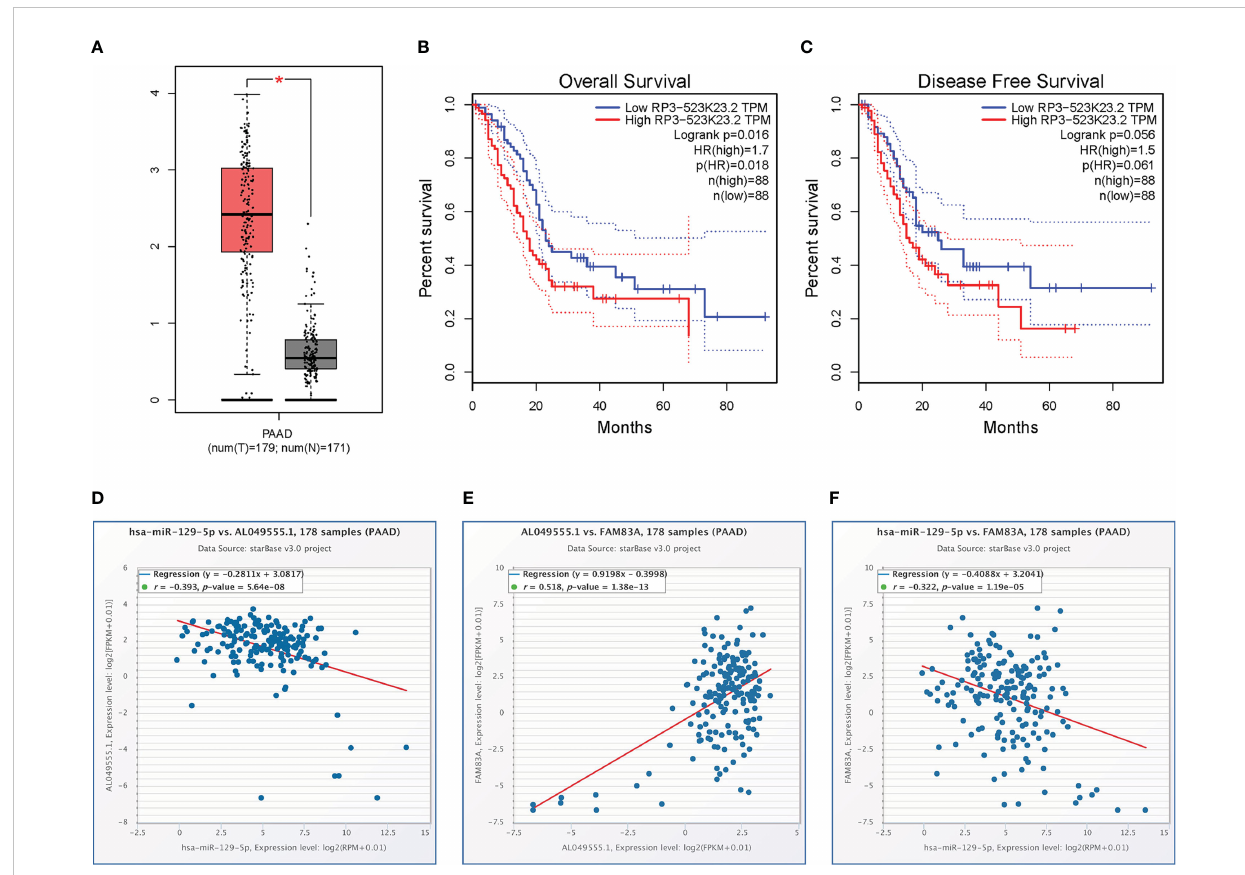
FIGURE 5 Expression analysis and survival analysis for AL049555.1, and relationship among AL049555.1/hsa − miR − 129 − 5p/FAM83A axis: (A) The expression of AL049555.1 based on TCGA and GTEx. (B-C) survival analysis of OS and RFS for AL049555.1. (D) The AL049555.1 was strong negatively corelated with hsa-miR-129-5p. (E) The AL049555.1 was strong positively corelated with FAM83A. (F) hsa-miR-129-5p was strong negatively corelated with FAM83A. *p value <